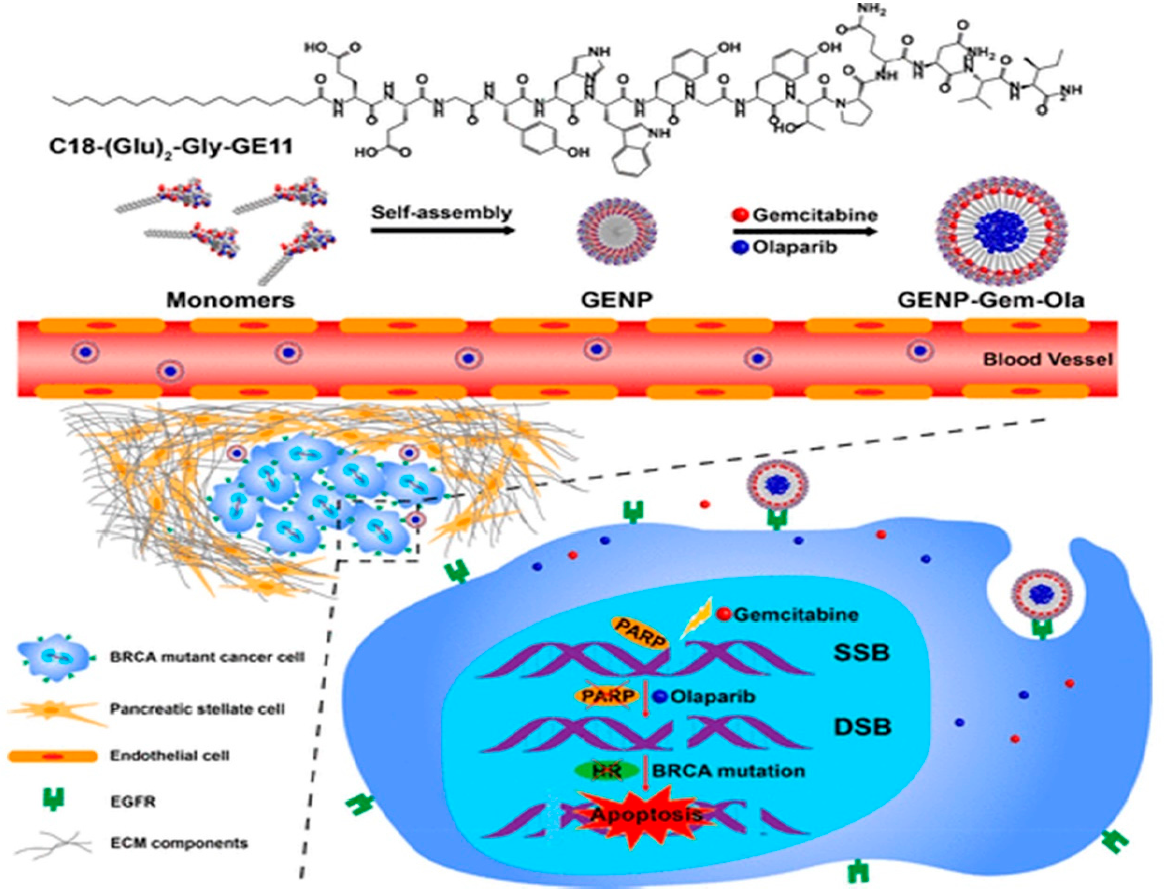
Figure 4. The schematic mechanism of EGFR-targeting self-assembled NPs for codelivery of olaparib and gemcitabine in the BRCA mutant pancreatic cancer. Reprinted with permission from ref. [116]. Copyright 2018 American Chemical Society.